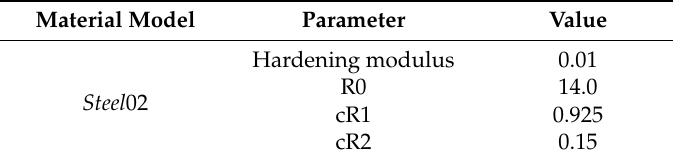
Table 8. Steel 02 model parameters considered in the column numerical